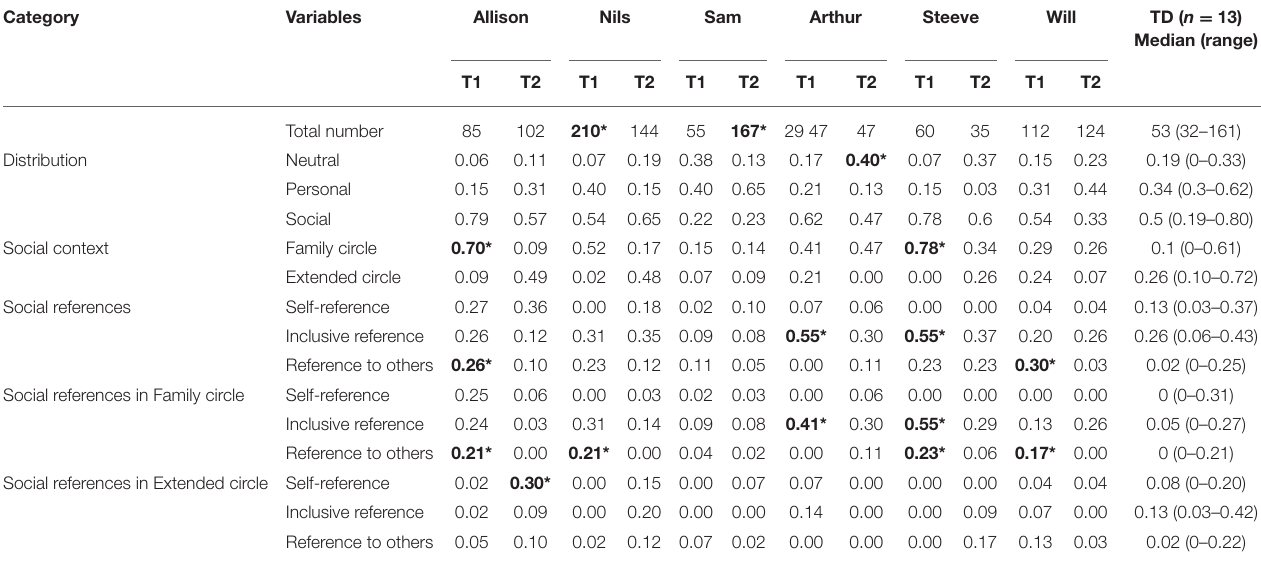
TABLE 5 | Social reference, social context and social positioning scores for the three ASD participants included in SIAM program (Allison, Nils and Sam) and for three ASD participants controls (Arthur, Steeve and Will). Category